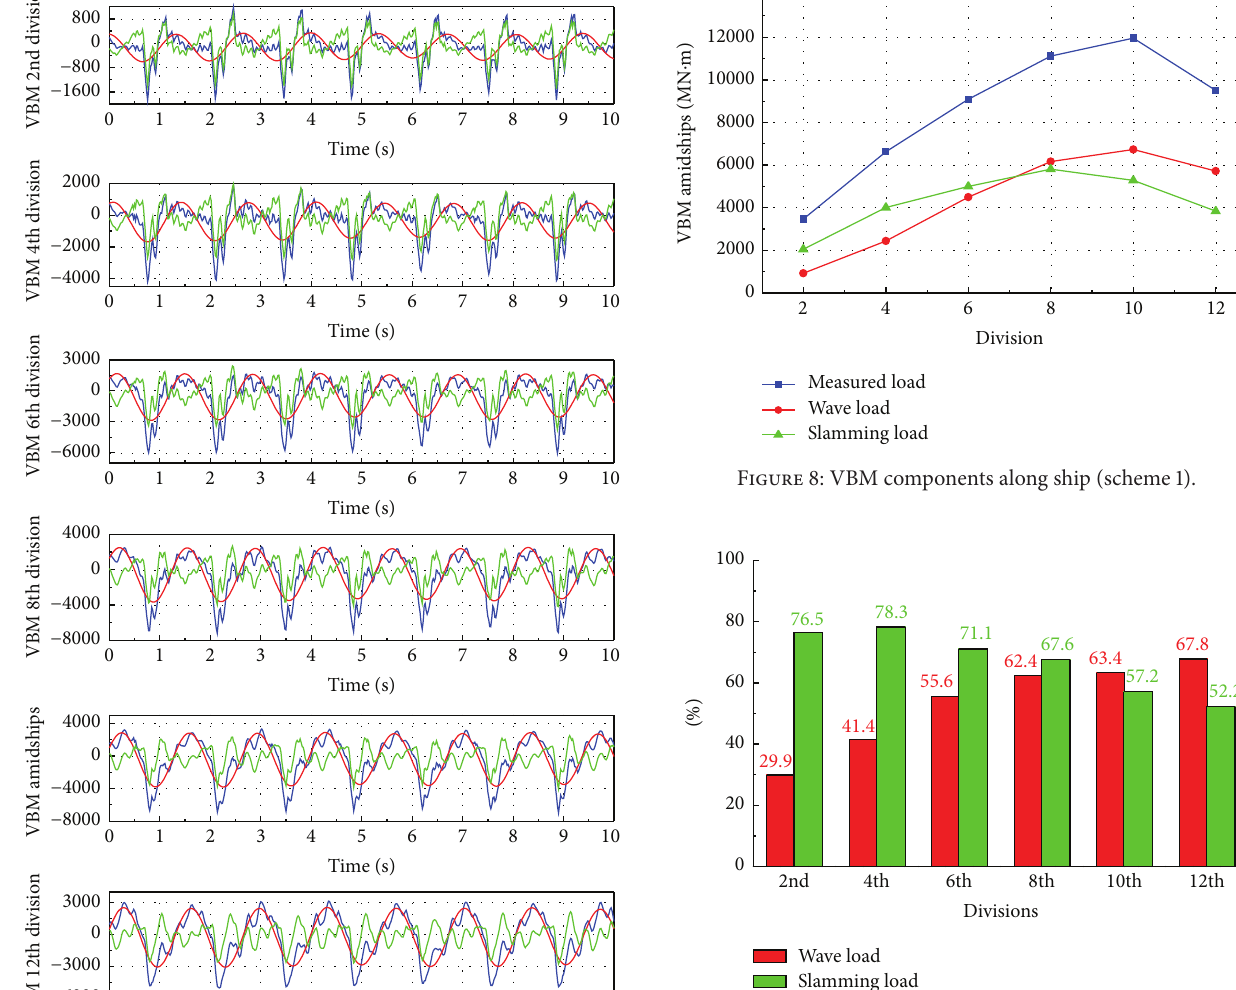
Figure 9: Ratios of components load to combined VBM load (scheme